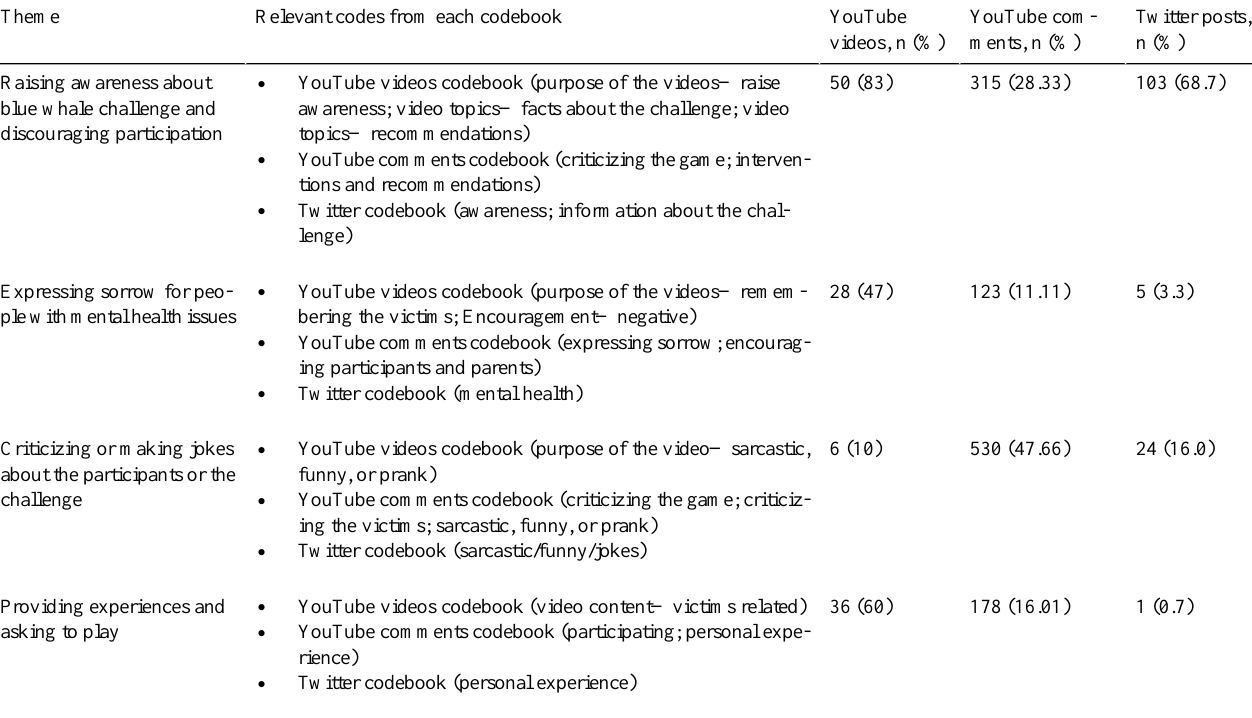
Table 3. Common themes and corresponding codes among the 3 data types.